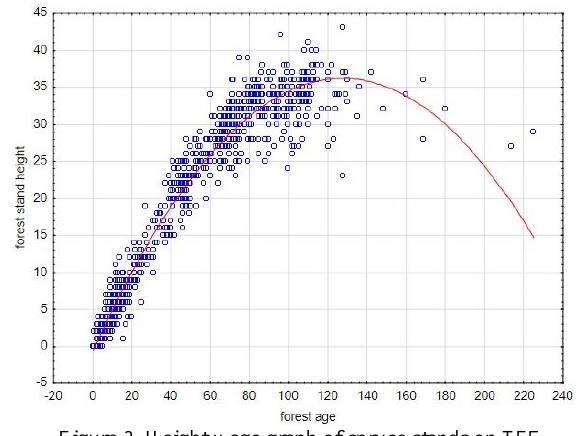
Figure 3. Height x age graph of spruce stands on TFE The results of the measurements in a representative spruce forest and statistical calculations show that the tree growth curves rises relatively quickly from the beginning (young canopy), but becomes more flattened at the higher